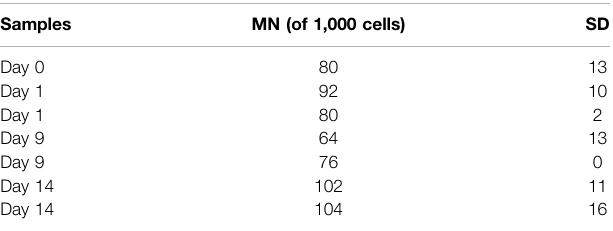
TABLE1| MNformationon1000-cellsamplesofCHOsuspensioncellscultivated under 0.66-T static MF exposure for 14 days and SD.